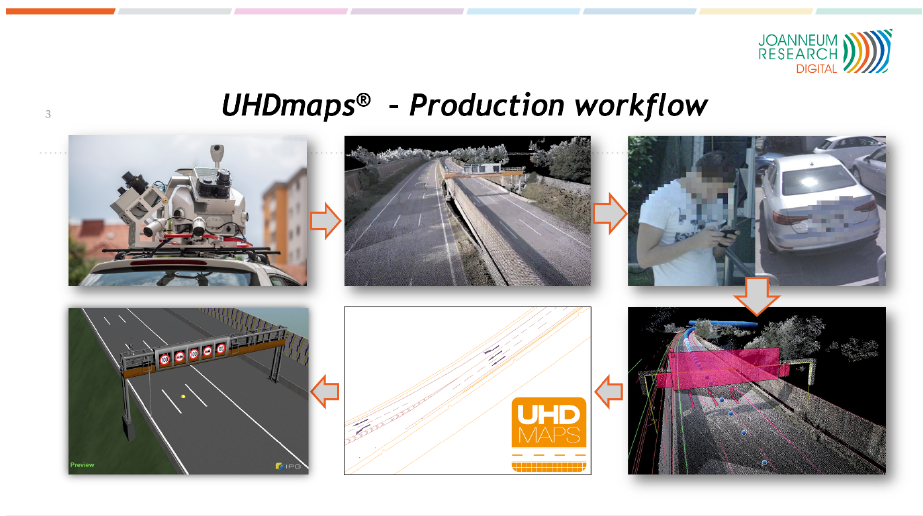
Figure 3. Digital Twin production workflow which is an ongoing subject of research at Joanneum Research.